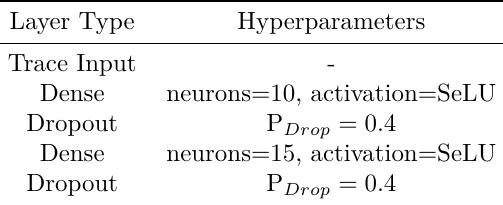
Table 5: Network configuration of